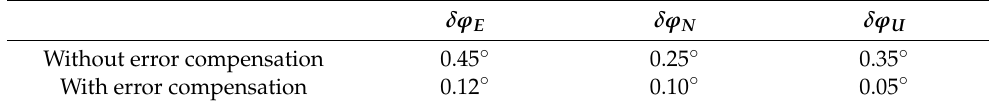
Figure 13. The comparison of attitude angle error. Table 2. Maximum attitude angle errors. Table 2. Maximum attitude angle errors.